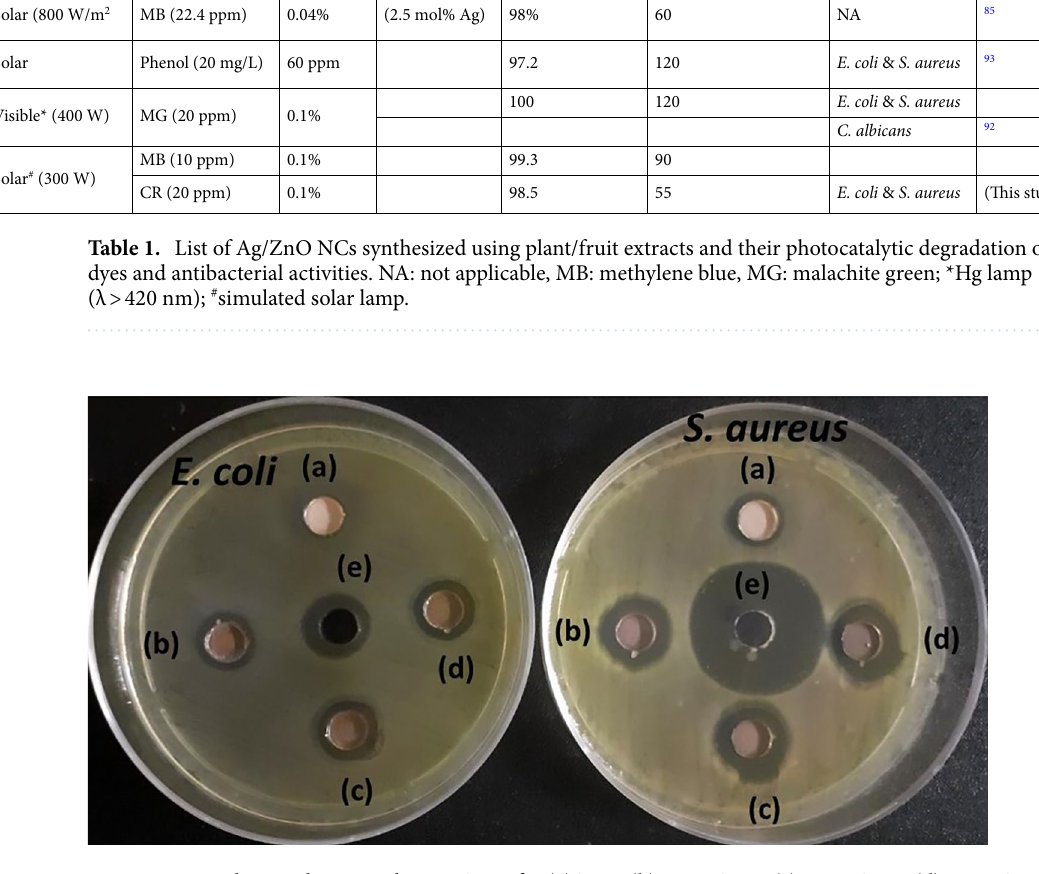
Figure 12. Antibacterial activity showing ZOIs for ( a ) ZnO, ( b ) Ag 0.2 @ZnO, ( c ) Ag 0.4 @ZnO, ( d ) Ag 0.8 @ZnO NCs (2 mg; 40 mg/mL), and ( e ) ampicillin (positive control) against E. coli and S. aureus